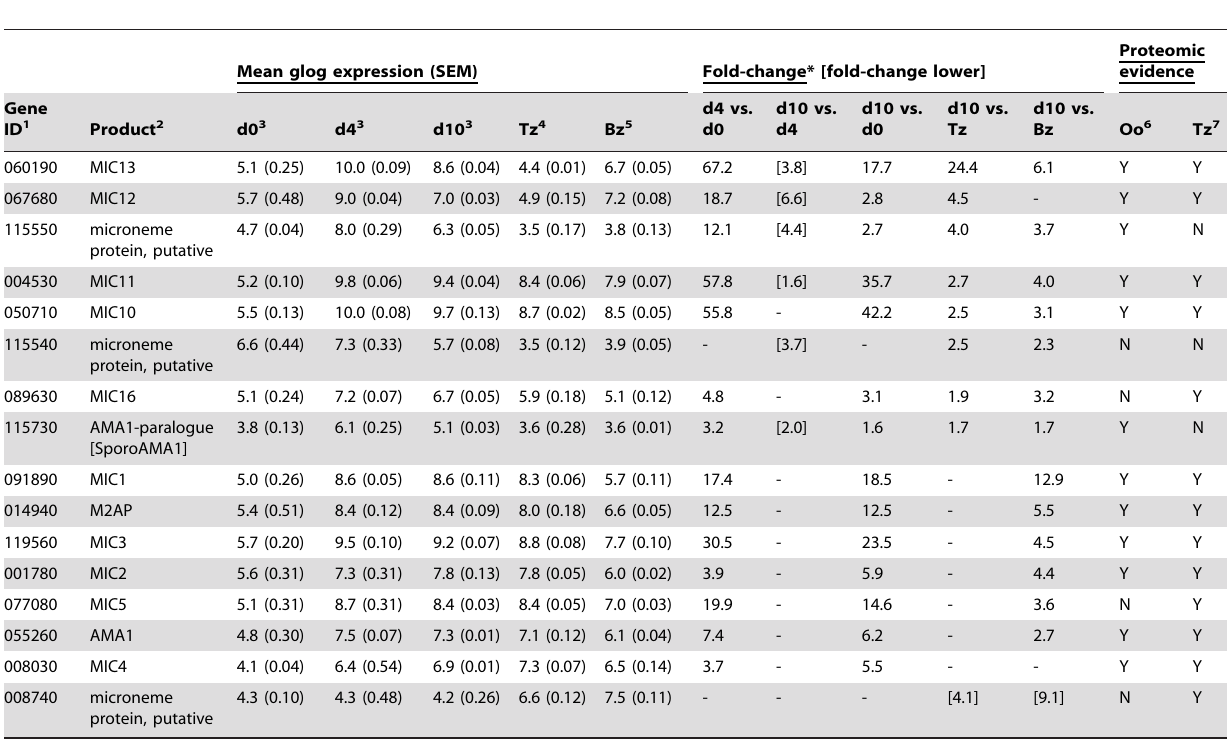
Table 5. Functionally interesting genes of Toxoplasma gondii oocysts at different stages of maturation with a comparison to bradyzoite and tachyzoite expression levels –